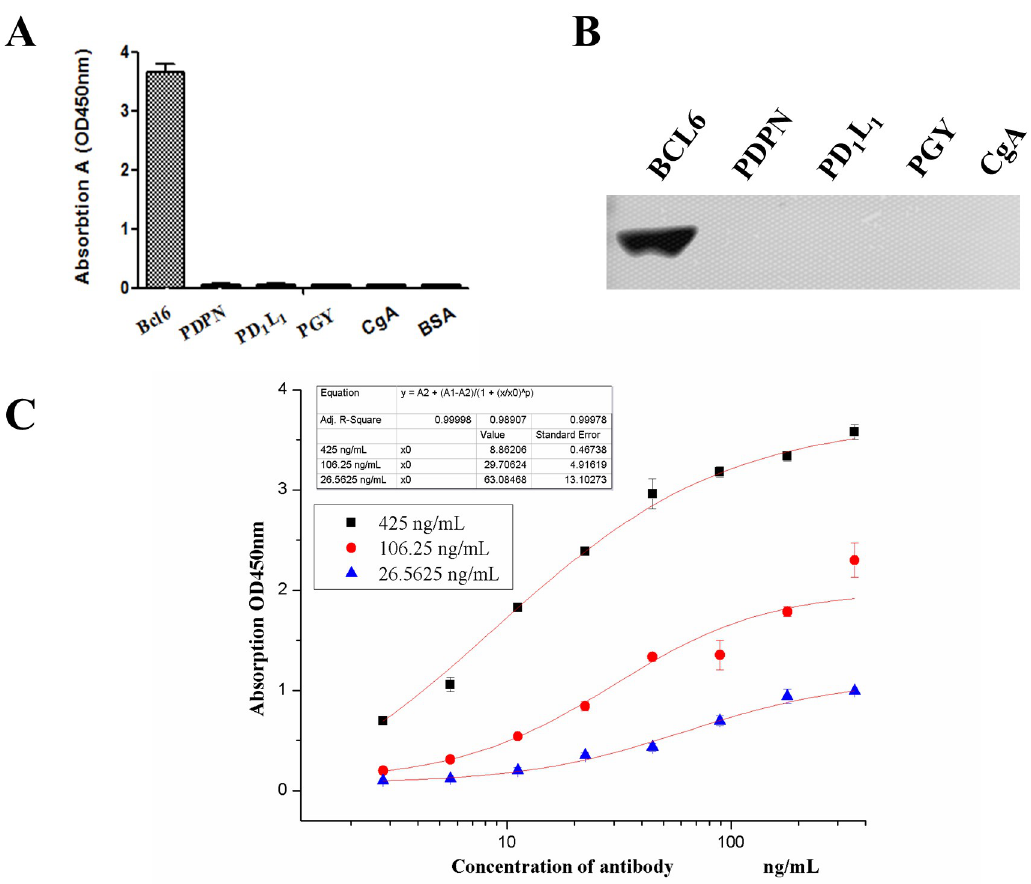
Fig 4. Characterization of 1E6A4 mAb. (A) The specificity of the 1E6A4 mAb was determined by indirect ELISA (BCL6: B-cell lymphoma 6 protein; PDPN: Podoplanin; PD1-L1: Programmed cell death 1 ligand 1; PGY: P-glycoprotein; CgA: Chromogranin A; BSA: Bovine serum albumin). (B) The specificity of the 1E6A4 mAb was determined by Western Blot. (C) Affinity of 1E6A4 mAb was analyzed by iELISA. Different concentrations (26.56, 106.25, and 425.00 ng/mL) of coating antigen (BCL6) were used. The affinity constant is determined as 5.12 × 10 10 L/mol.